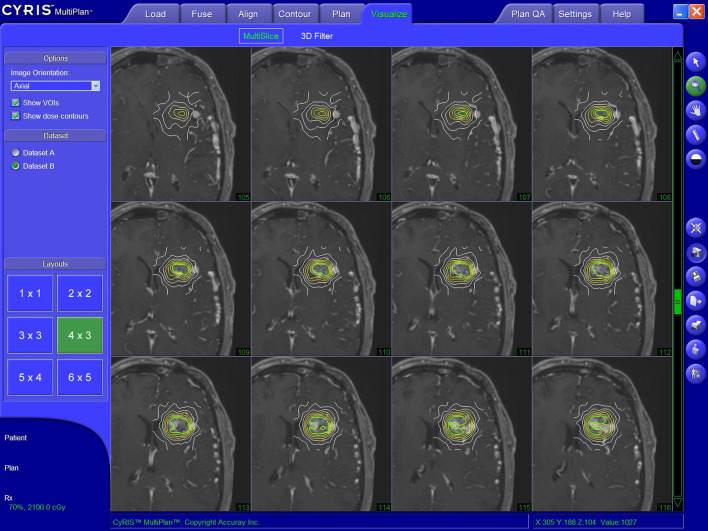
Illustratory target volume planning achieved with the MultiPlan planning software (Accuray Inc., Sunnyvale, CA, USA).